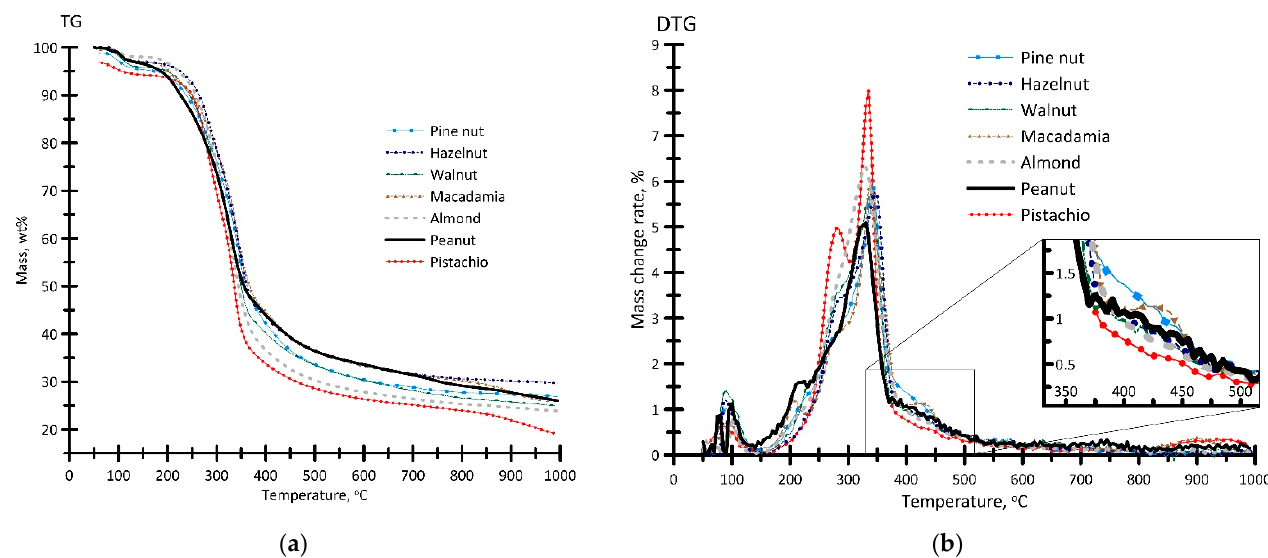
Figure 3. TG ( a ) and DTG ( b ) profiles for the process of thermal decomposition of the samples in an inert atmosphere. Argon flow rate—150 mL/min, heating rate—10 °C/min, sample weight ≈ 15 mg. Table 2. Thermal conversion parameters.